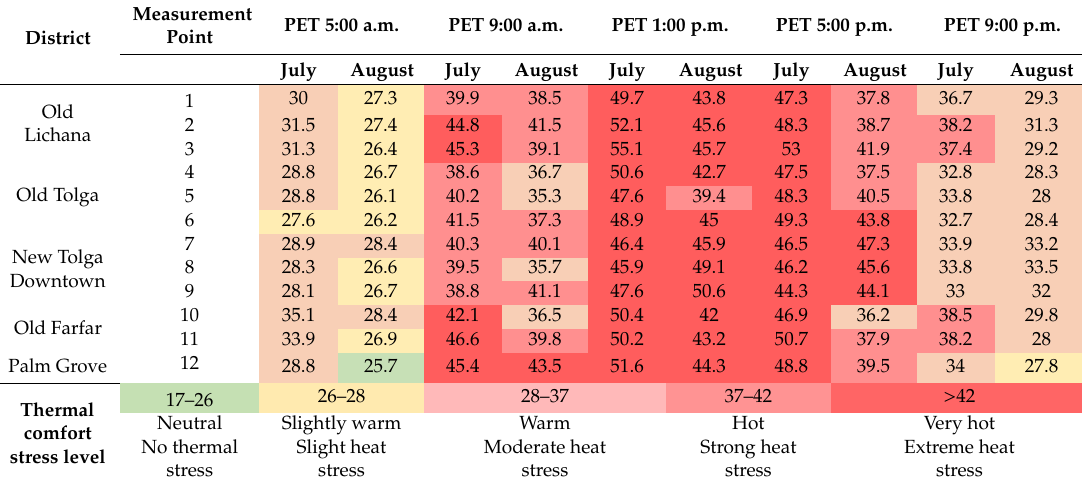
Table 4. Assessment of the outdoor thermal comfort level stress via PET index in the five study cases between July and August. District